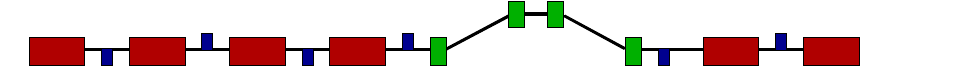
MICROBUNCHING INSTABILITY IN A CHICANE: TWO- . .